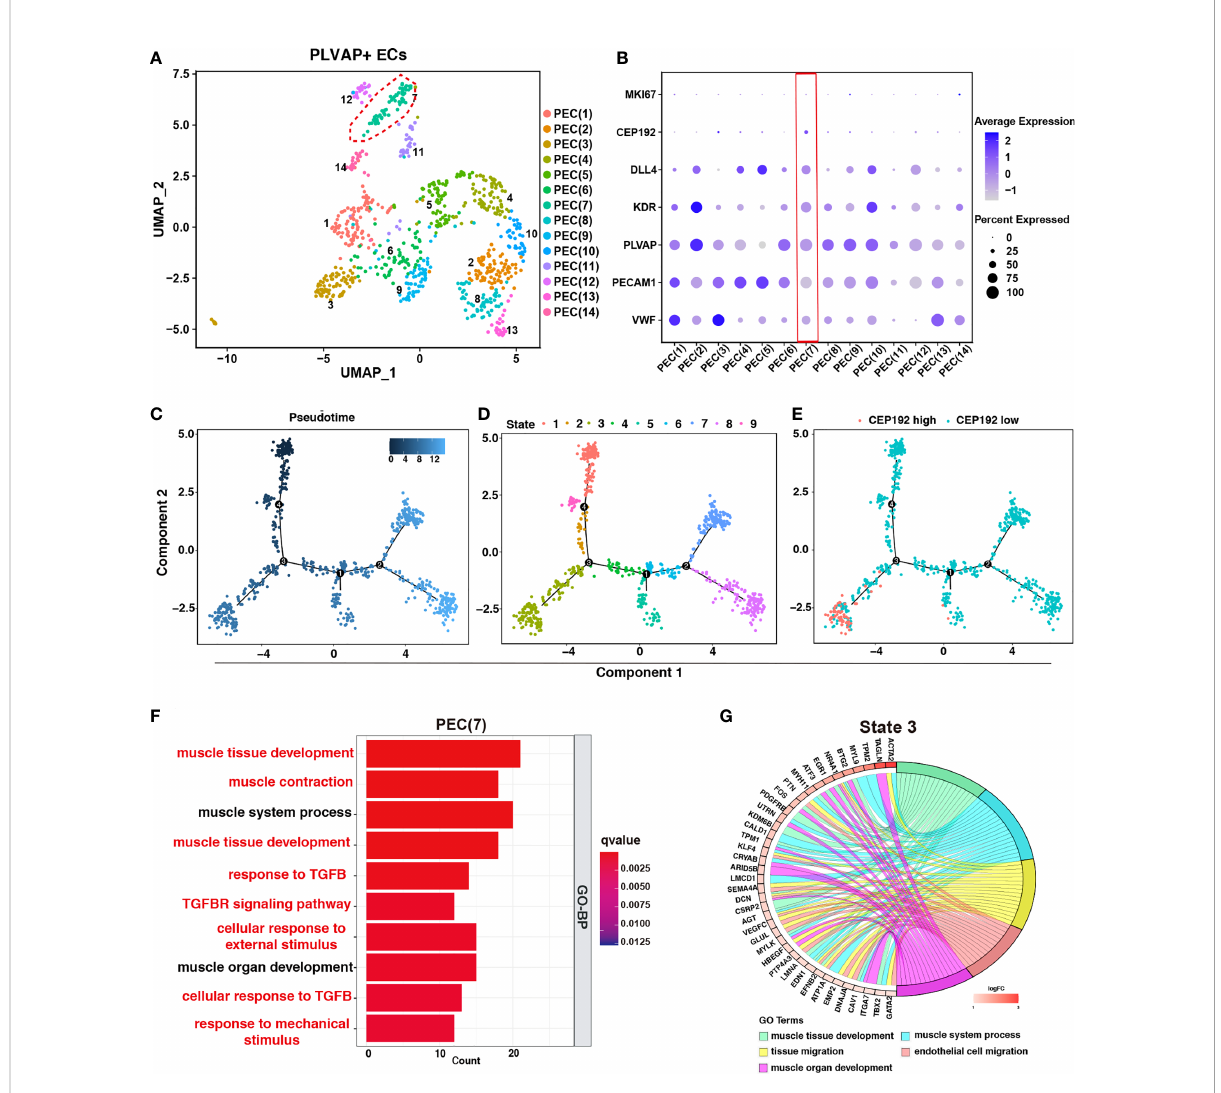
FIGURE 5 The effects of CEP192 on the function of PLVAP+ ECs. (A) UMAP was colored by 14 subpopulations of PLVAP+ ECs. (B) Expression of CEP192 and EC-speci fi c marker genes in PLVAP+ EC subpopulations. Red boxes highlighted PLVAP+ EC clusters of high CEP192 expression. (C – E) Single-cell trajectory of pseudotime (C) , state (D) , and CEP192 expression (E) . (F) Box plot showing the GO-BP enrichment results of PEC(7). (G) Chord diagram exhibiting the GO-BP enrichment results of PLVAP+ ECs in state